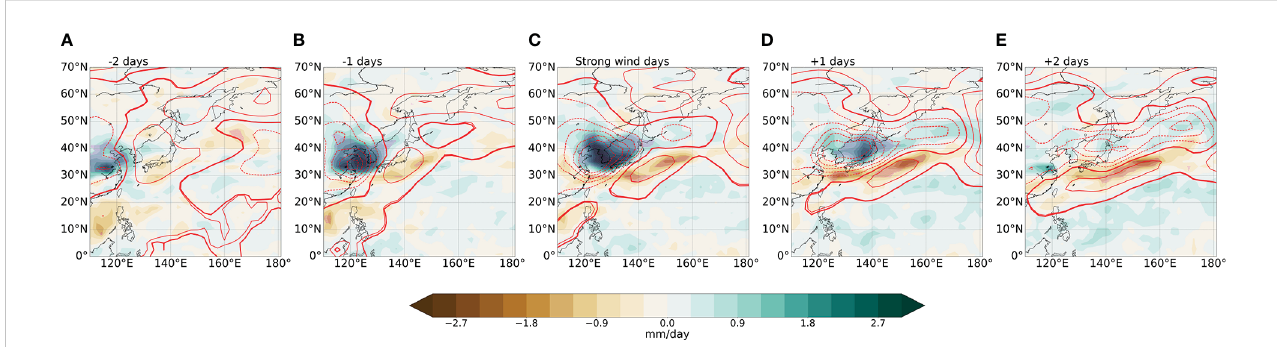
FIGURE 4 (A – E) Temporal evolution of the sea level pressure (SLP, red contours) and the precipitation (PREC, green and brown shades) anomalies before and after the days of strong wind (top 33% daily) in June. Black arrows guide through the chronological order. Contour interval is 0.3hPa. Stipples indicate signi fi cance at 95%